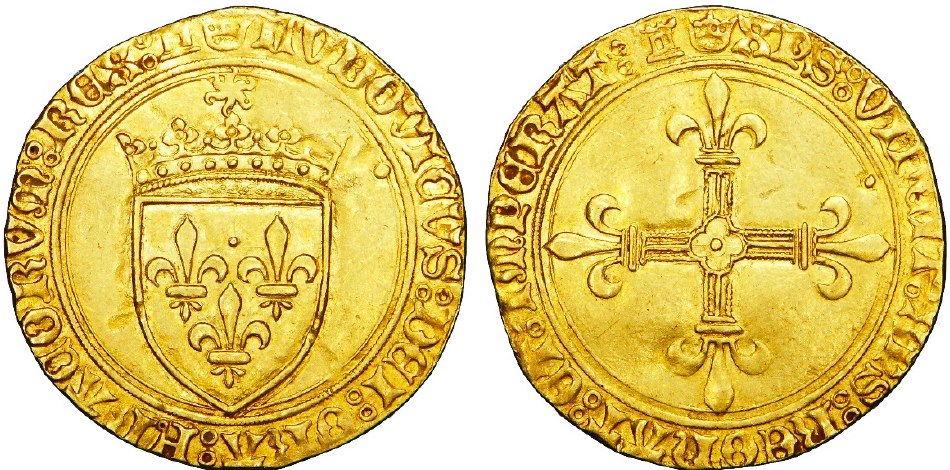
Figure 1. Tours workshop, Ecu d’Or , gold, Private ownership. Source: cgb.fr (Numismatique Paris), Wikimedia Commons, CC BY-SA 3.0 license.